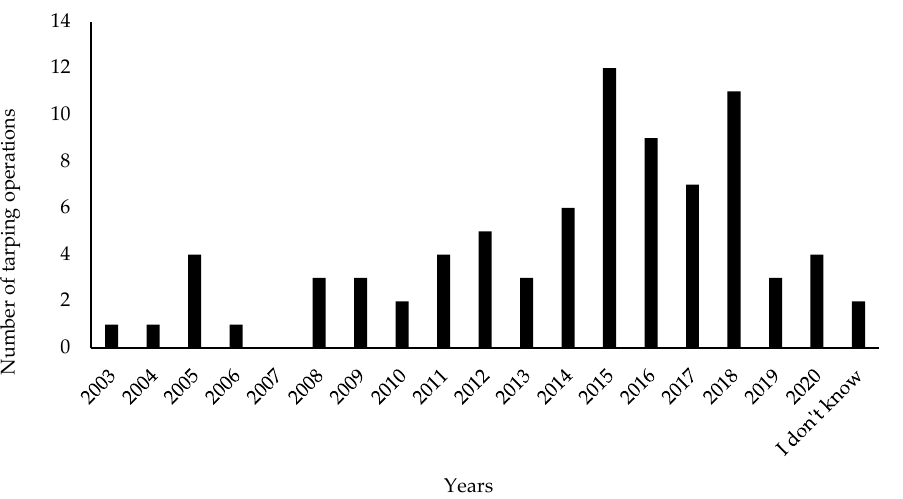
Figure 3. Number of tarping operations identified from the questionnaire according to the starting date of the operation, for a total of 81 tarping operations.